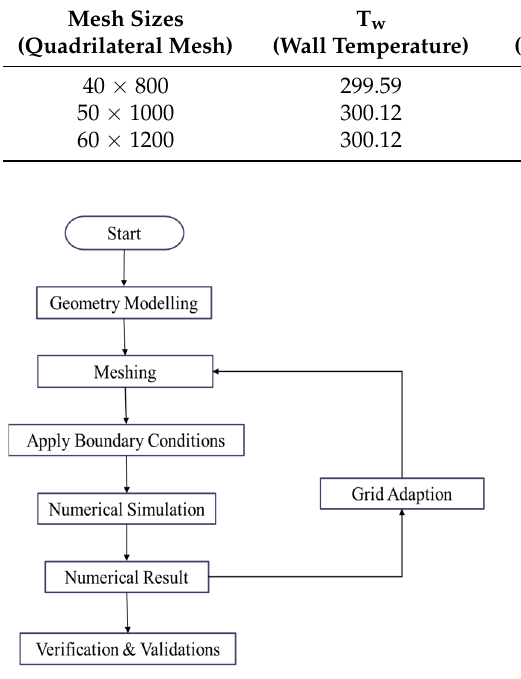
Figure 2. Methodology. Figure 2.